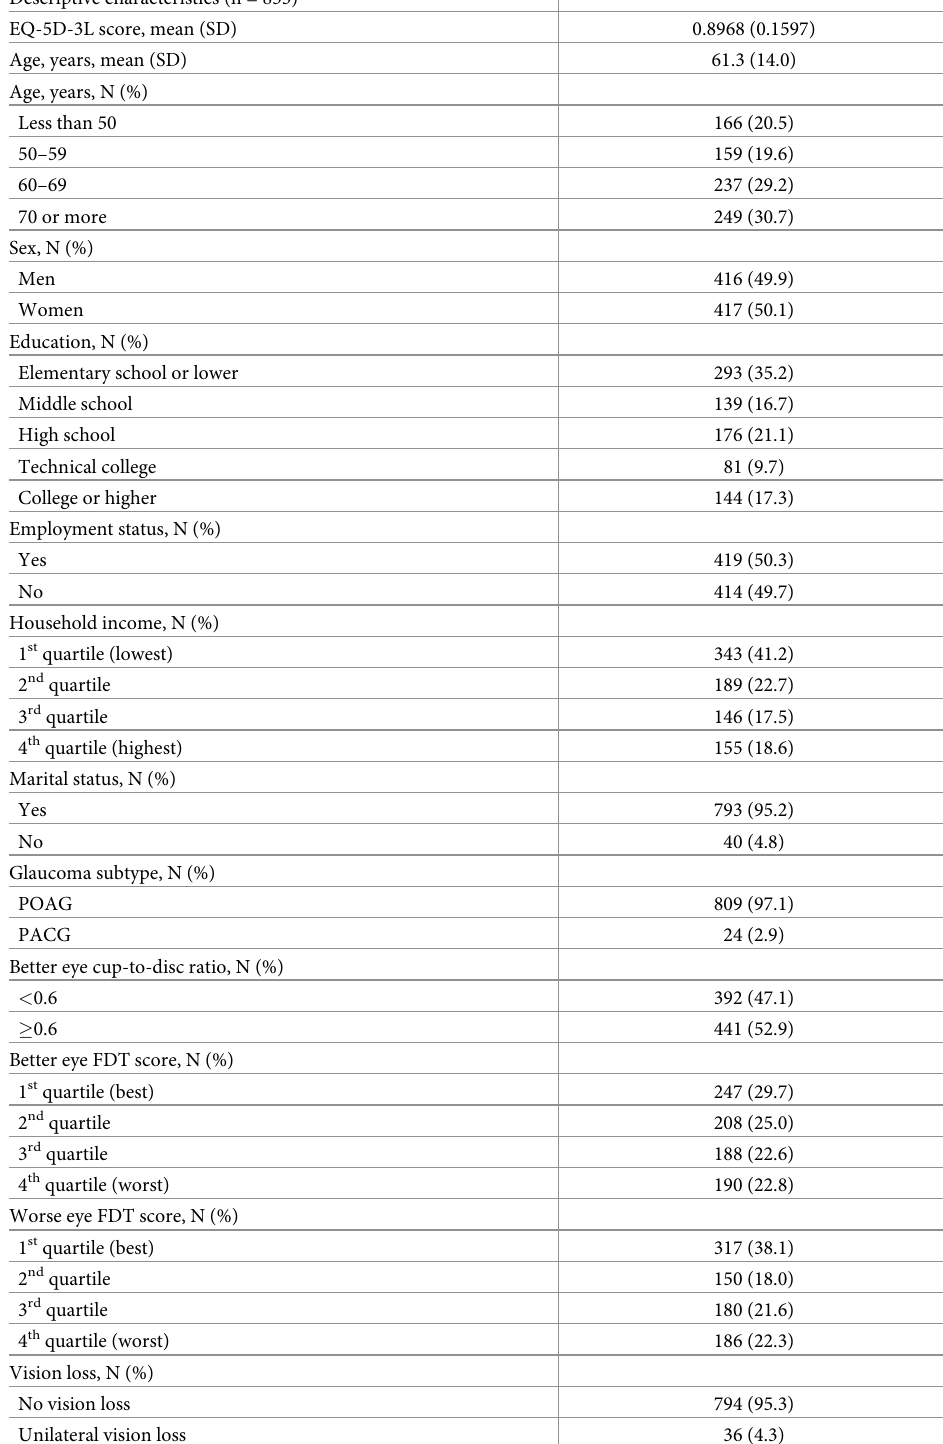
Table 1. Descriptive characteristics of the study